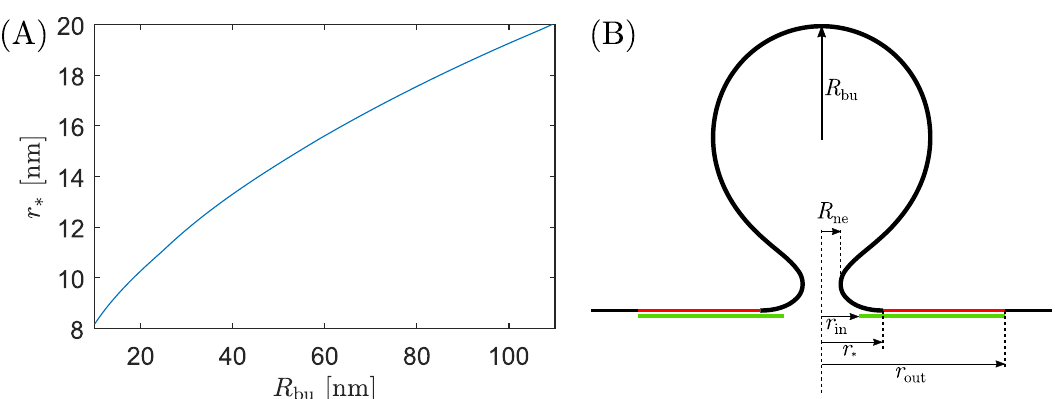
Fig 7. Geometric constraints on fission by cone-shaped assemblies. (A) Attachment radius r (cid:3) at the moment of neck closure corresponding to R ne = 3 nm, as a function of bud radius R bu , for the particular case of a fully flattened cone with apex angle α = 90˚. For scission to be possible in this model, the inner and outer radii of the cone must satisfy r in (cid:20) r (cid:3) (cid:20) r out , see